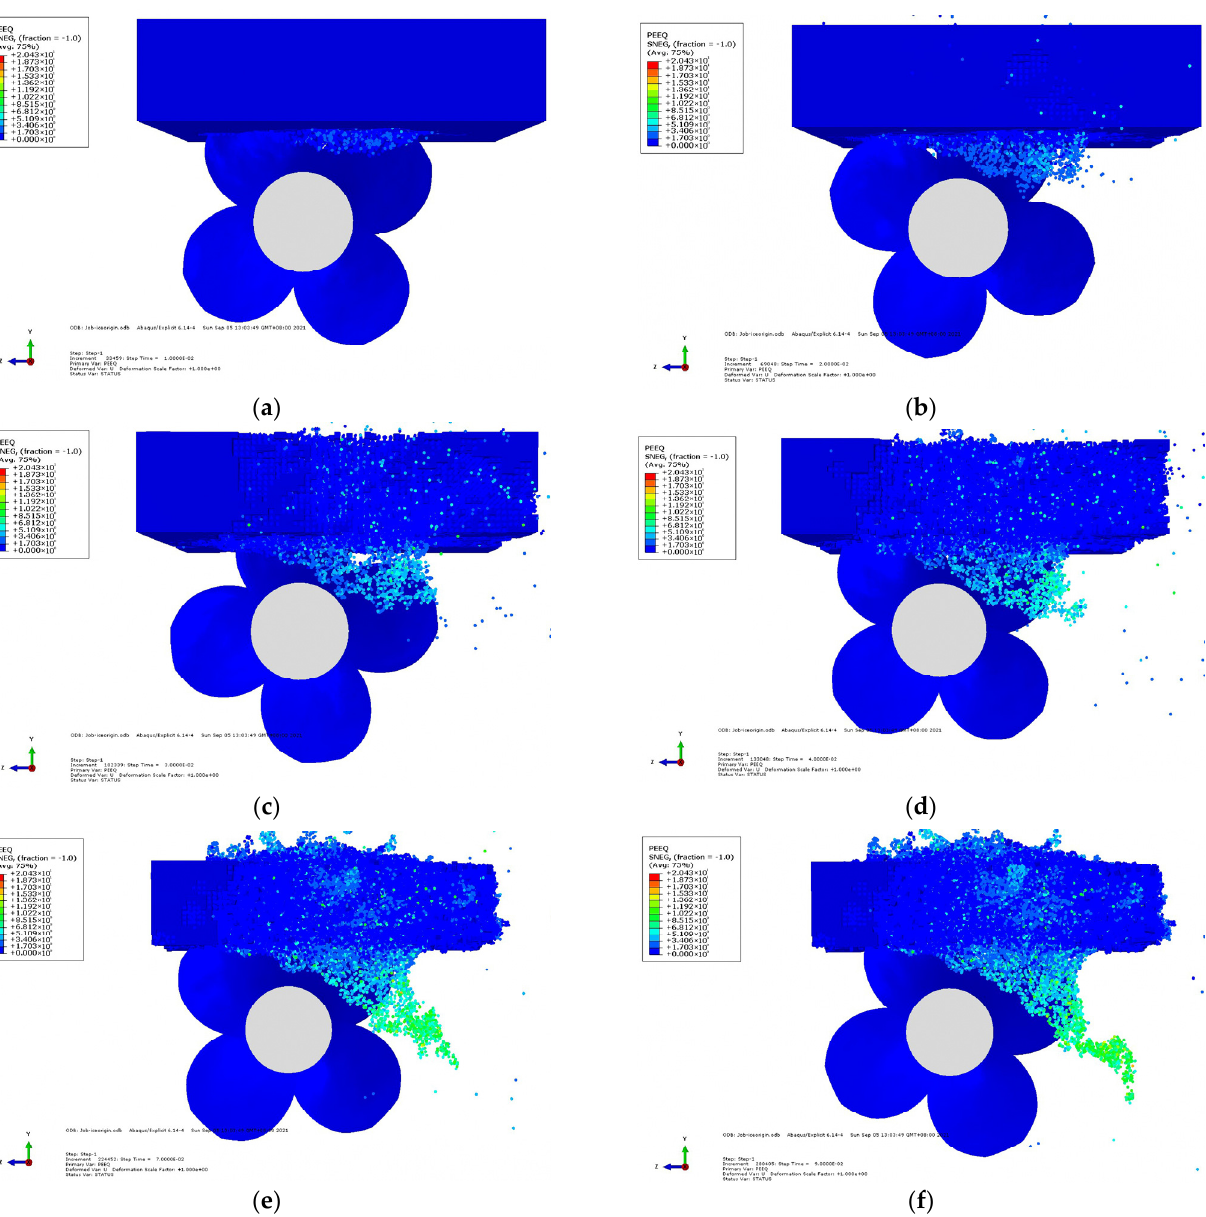
Figure 13. Propeller and ice cutting state. ( a ) 0.01 s; ( b ) 0.02 s; ( c ) 0.03 s; ( d ) 0.04 s; ( e ) 0.07 s; ( f ) 0.09